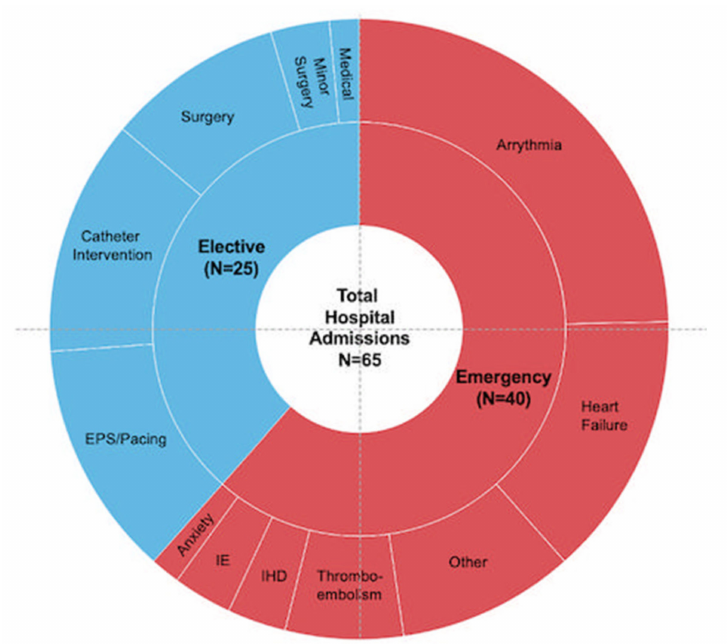
Figure 5. Reasons for hospital admissions. (IHD: Ischaemic Heart Disease; IE: Infective Endocarditis; EPS: Electrophysiology